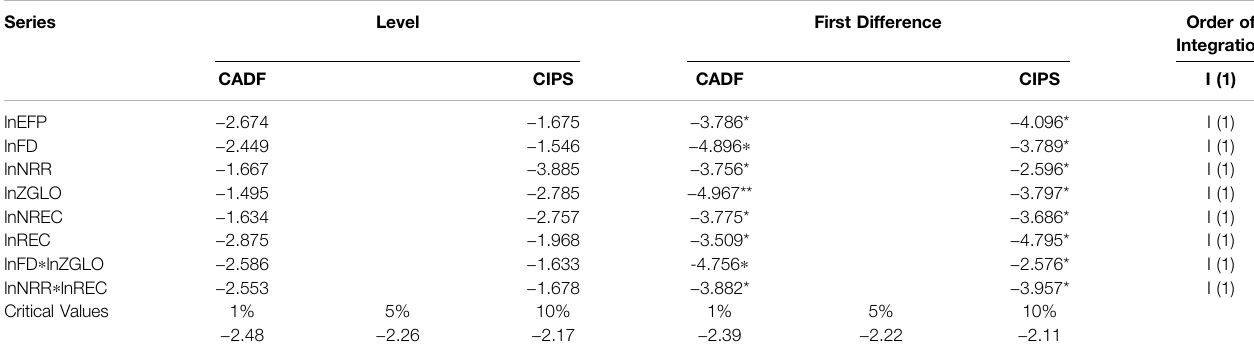
TABLE 6 | Unit root tests results.